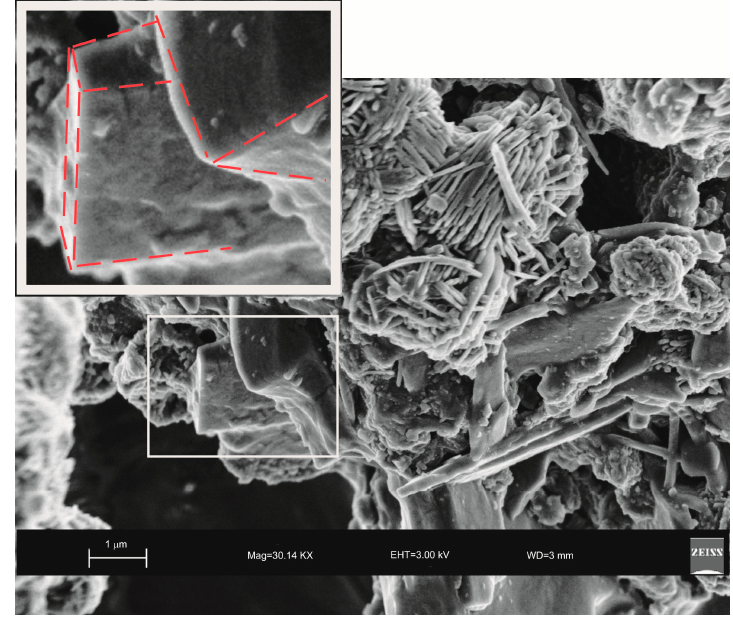
Figure 8. SEM image showing cubic face morphology of relict LTA zeolite (highlighted and enlarged part) detectable between sodalite crystals.